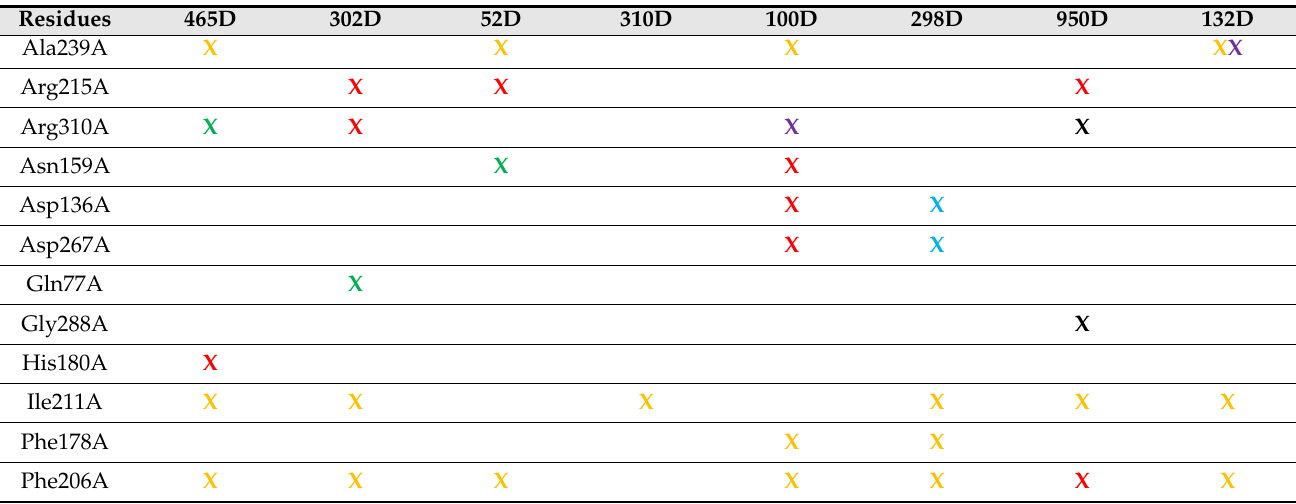
Figure 5. Plot showing Binding Affinity (kcal/mol) vs. No. of compounds (1D to 2194D). Table 1. Table showing eight ligands and types of interactions with nearby